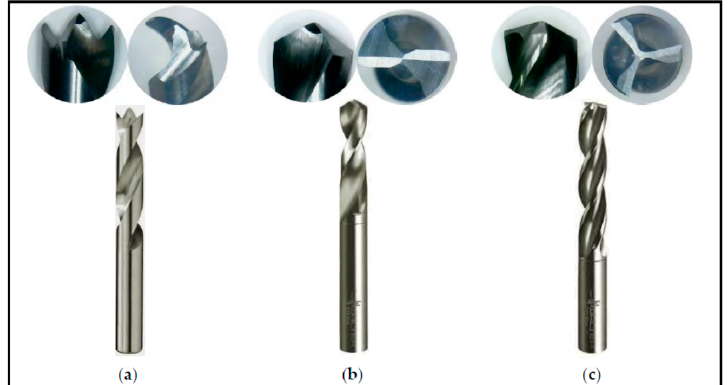
Figure 3. Drills used in the experiments: ( a ) Brad and Spur; ( b ) twist drill with two edges and ( c ) twist drill with three edges.